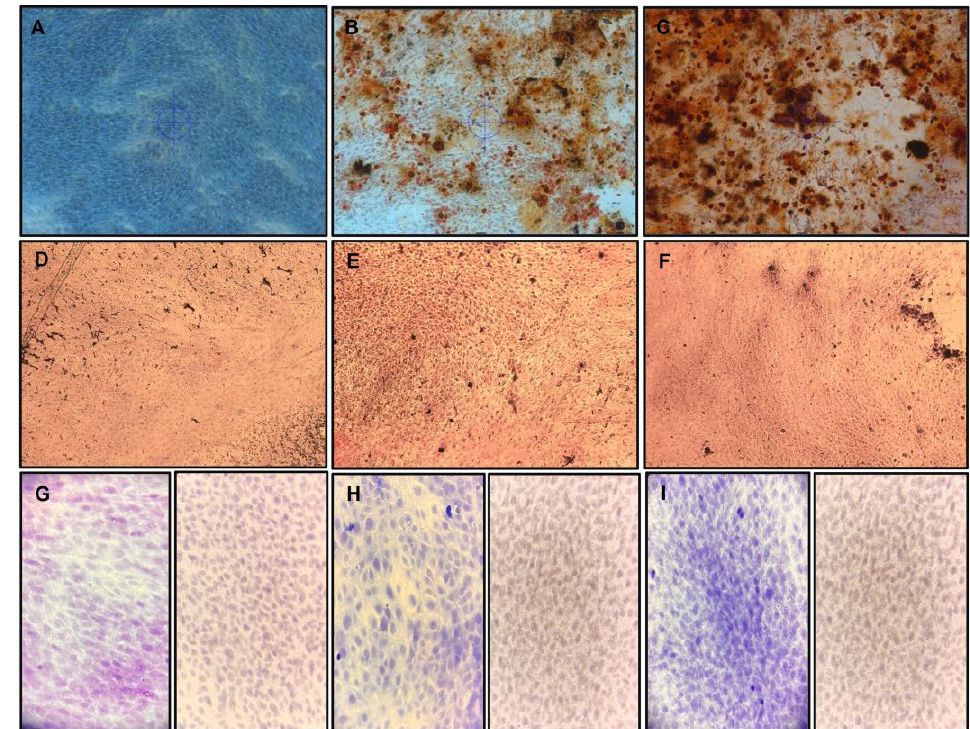
Figure 4. hDPSC differentiation to odontoblast-like cells in culture with or without EGCG for 10 days. hDPSCs (100% confluence, 6 PDL) were subcultured, differentiated to odontoblast-like cells, and evaluated by alizarin red stain ( A – C ), Von Kossa stain ( D – F ), and immunohistochemistry ( G – I ); Left = Masson trichrome stain, right = Vimentin antibody. ( A , D , G ) hDPSC controls were incubated with conventional culture medium; the hDPSCs did not exhibit matrix mineralization, and a small number of calcified nodes with collagen/vimentin. ( B , E , H ) hDPSCs were treated with the odontoblastic medium without EGCG, a small amount of matrix mineralization, and calcified nodes with collagen/vimentin. ( C , F , I ) hDPSCs were treated with odontoblastic medium containing 3.12 µ g/mL, exhibiting more matrix mineralization and more calcified nodes with Masson trichrome stain collagen/vimentin. All microphotographs were obtained under a light microscope at 20×. EGCG = (-)- Epigallocatechin - Gallate ; hDPSCs = human dental pulp stem cells.